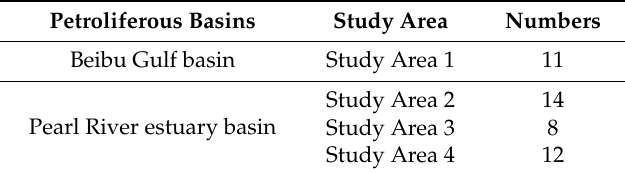
Table 3. Ground truth data of the offshore